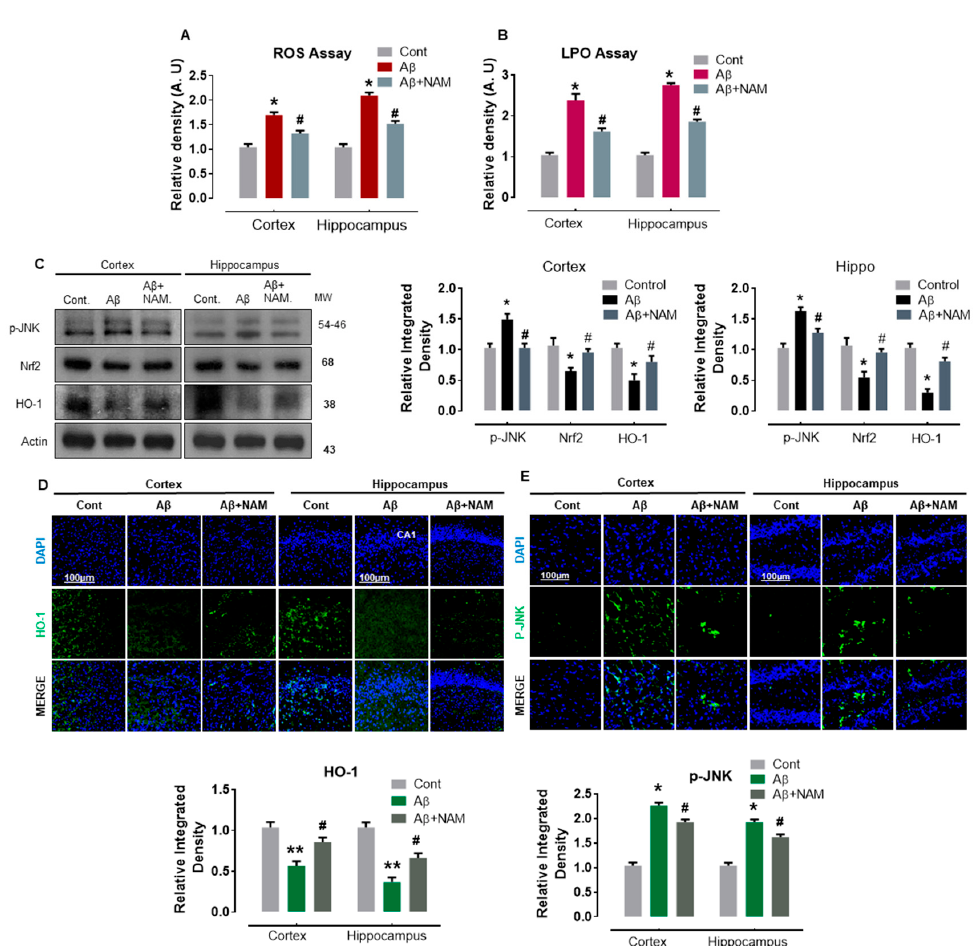
Figure 2. NAM Ameliorating the JNK activation, oxidative stress, and regulates Nrf2, HO-1 expression in A β 1–42 -induced Mouse Brains. ( A , B ) representative histograms showing the ROS/LPO assays in vivo. 6 animals were kept per group and each experiment was repeated 3 times, i.e., ( n = 6)/( n = 3) ( C ) Represents Western blot analysis of JNK, HO-1and Nrf2 proteins in mouse cortex and hippocampus, respectively. Scale bar (100 µm). ( D , E ) the immunofluorescence study was carried out of HO-1 and p-JNK in both cortical and hippocampal regions of mouse model. “Asterisk sign (*) indicated significant difference between control and A β injection group; hash sign (#) indicated significant difference between A β injection group and A β + NAM treated group. Significance: (*) # = p ≤ 0.05, (**) = p ≤ 0.01.”. Immunofluorescence analysis also confirmed the immunoblotting results for HO-1;